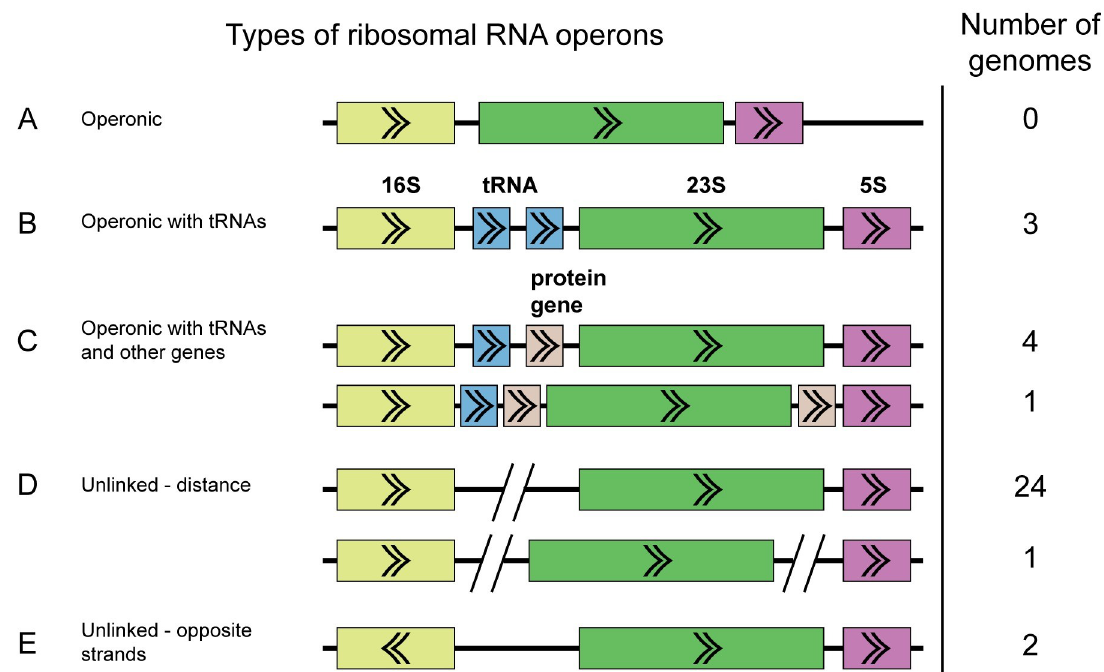
Fig 3. Diagram of placement types of ribosomal RNA genes. Number of genomes in this study for each category are indicated in the rightmost column. (A) Operonic. The 16S (yellow), 23S (green), and 5S (purple) ribosomal RNA genes are in an operon. (B) Operonic with tRNAs (blue). The three ribosomal RNA genes are still in an operon, but one or more tRNAs are located in the spacer between the 16S and 23S genes. (C) Operonic with tRNAs and protein coding genes (beige). The three ribosomal RNA genes are still in an operon, but one or more tRNAs or protein coding genes are located in the spacer between the 16S and 23S genes or 23S and 5S genes. It is not unusual to find that the protein coding gene is a homing endonuclease. (D) Unlinked ribosomal RNA genes by distance. The 16S gene is unlinked from the 23S and 5S genes, or the 23S is also unlinked from the 5S gene, by enough distance ( > 2000bp) and intervening genes on the opposite strand where it is not possible for them to be transcribed from the same promoter. (E) Unlinked ribosomal RNA genes that are on opposite strands. The 16S is on the opposite strand from the 23S and 5S